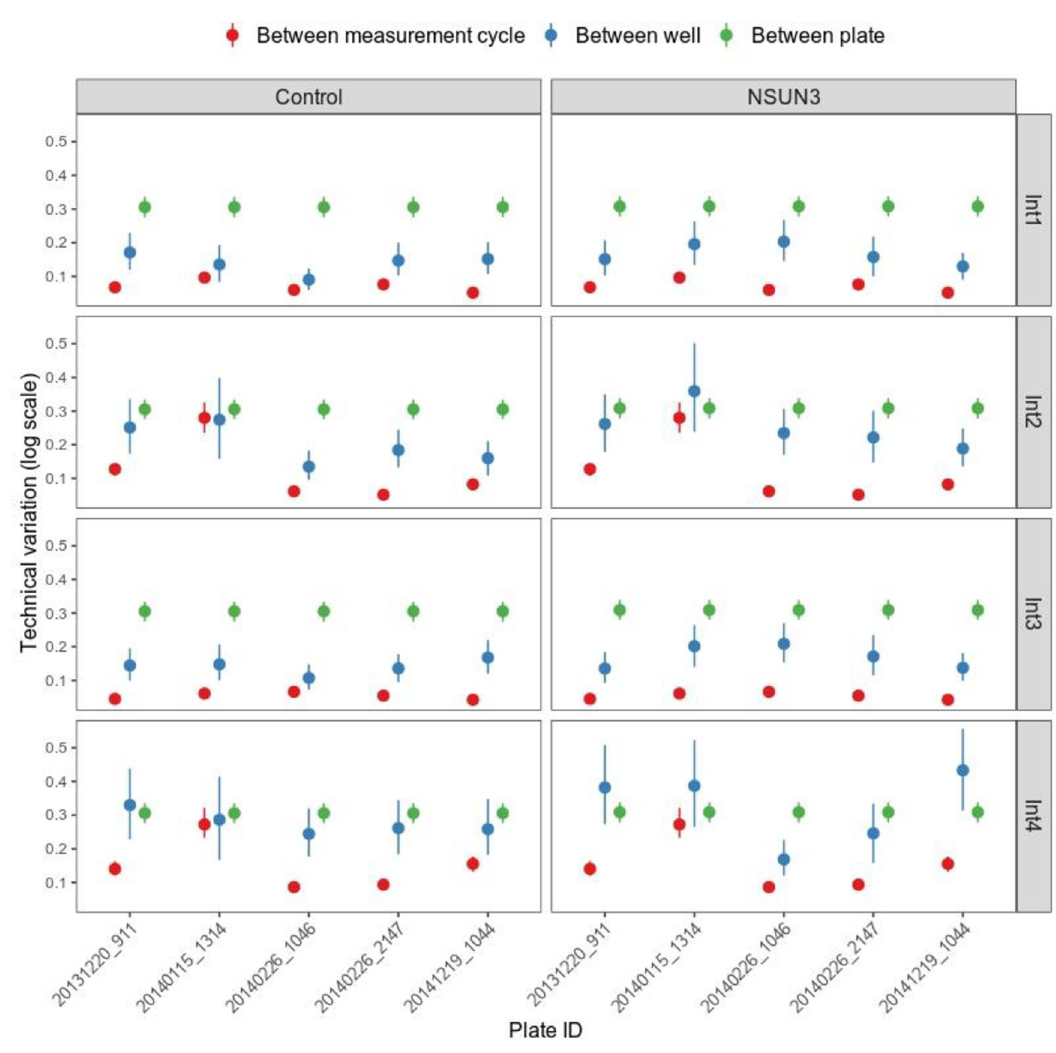
Fig 2. Technical variations in Seahorse XF OCR data of experiments based on the patient cell line with mutation in NSUN3 gene and the control cell line. Int1, Int2, Int3 and Int4 represent initial, oligomycin, FCCP and antimycin/rotenone phase. All the variations were on log scale. The dots are the posterior mean and the line segment represent the 95% credible